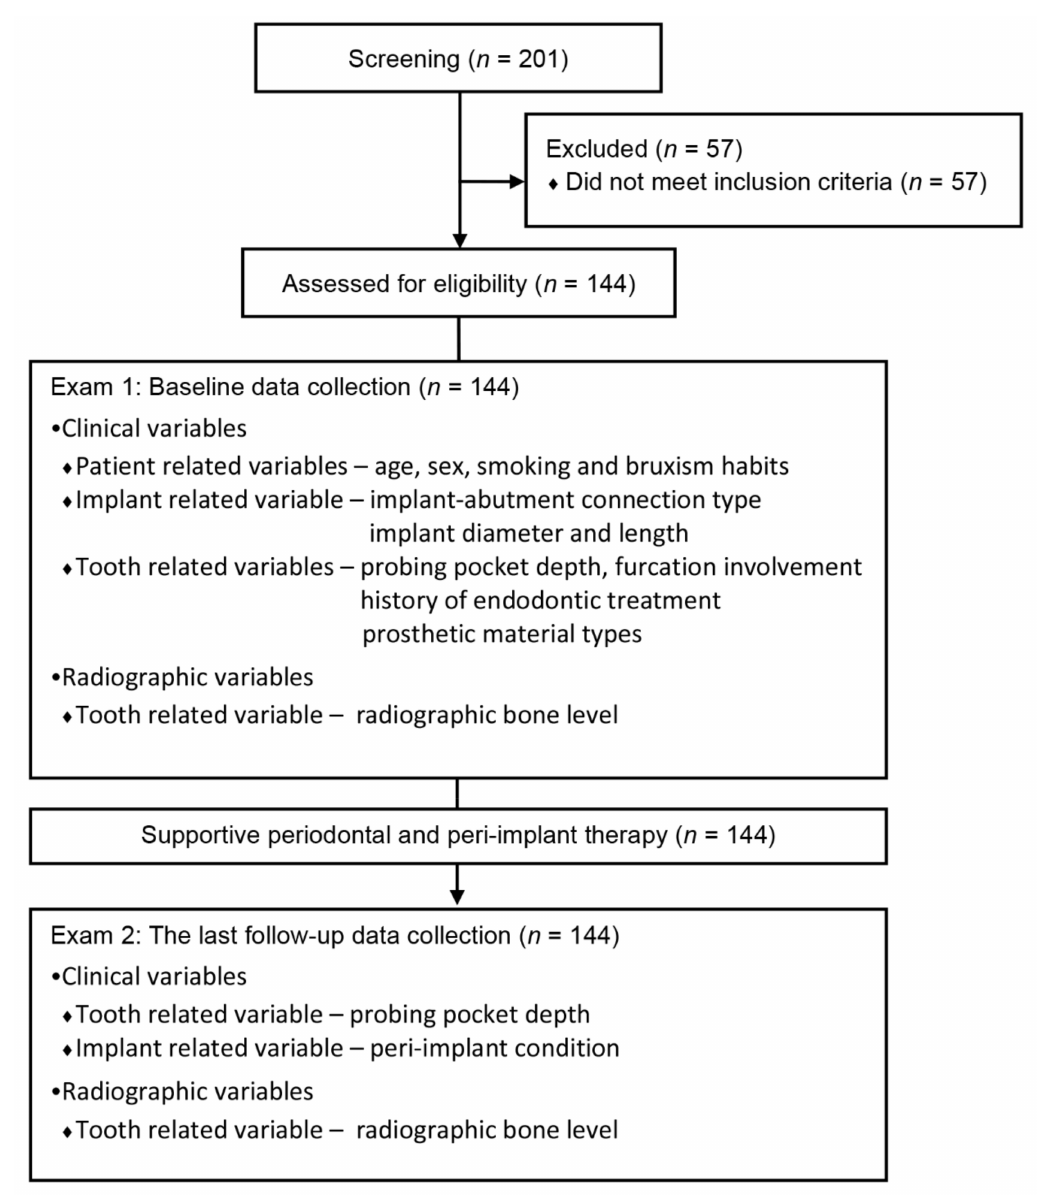
Figure 1. Flow chart of the